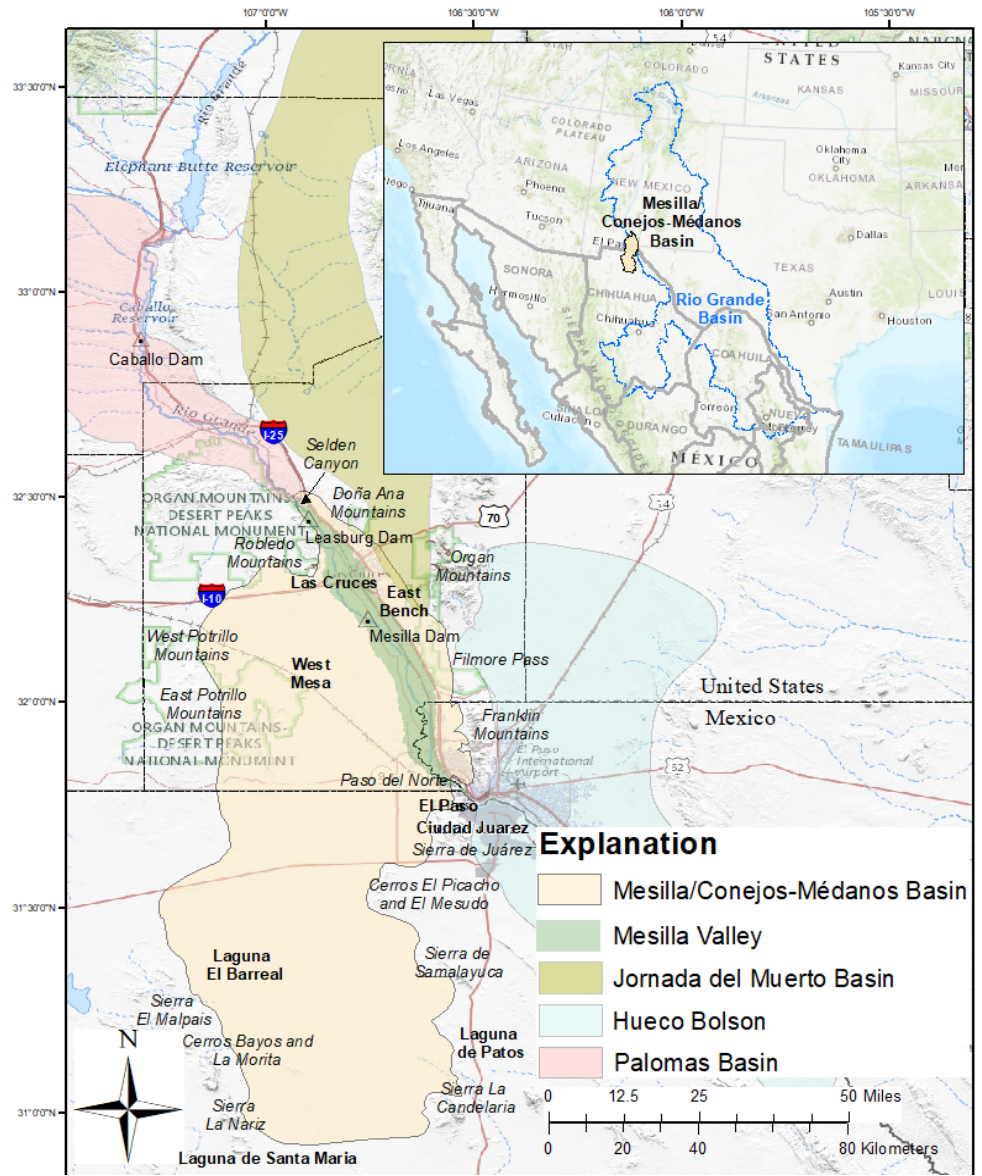
Figure 1. Location of the Mesilla/Conejos-Médanos Basin in Texas and New Mexico (U.S.), as well as Chihuahua (Mexico). Base terrain and geographic references from U.S. Geological Survey (2021) [4], Teeple (2017) [5] and Driscoll and Sherson (2016) [6]. The geographic coordinate system is the North American Datum of 1983.